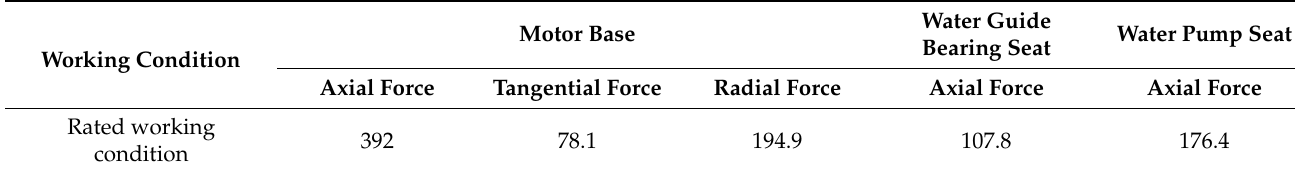
Table 3. Dynamic load of water pump unit (KN).